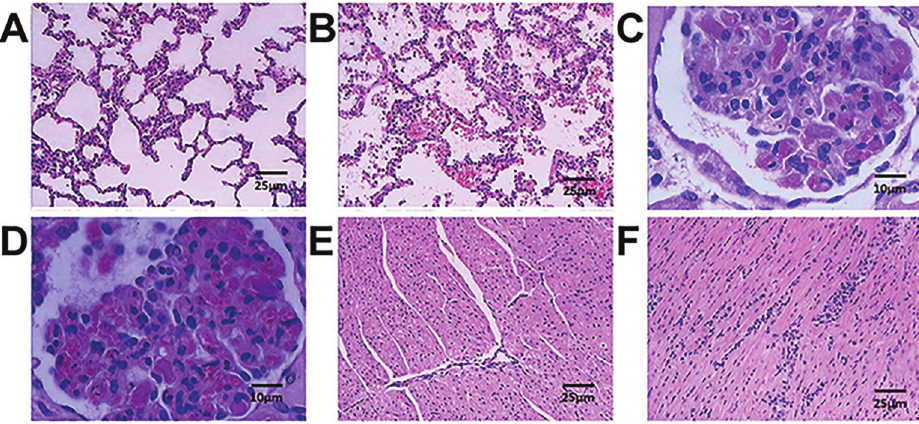
Figure 3. Photographs of pathological fi ndings in tissues from male pigs induced with acute respiratory distress syndrome that received continuous veno-venous hemo fi ltration therapy (experimental) or conventional supportive therapy (control). A , Lung tissue of the experimental group, where slightly thickened alveolar walls are seen, with no obvious leukocyte in fi ltration. B , Lung tissue of the control group, where wider alveolar septa, fi brous tissue hyperplasia, and scattered in fi ltration in lymphocytes, plasma cells, and neutrophils are seen. C , Kidney tissue of the experimental group, where the glomerulus is almost normal. D , Kidney tissue of the control group, where a little extravasated blood in glomerulus and foci of necrosis are seen. E , Heart tissue of the experimental group, which is essentially normal. F , Heart tissue of the control group, where the scattered in fi ltration of myocardial interstitial is seen in the lymphocytes and plasma cells.